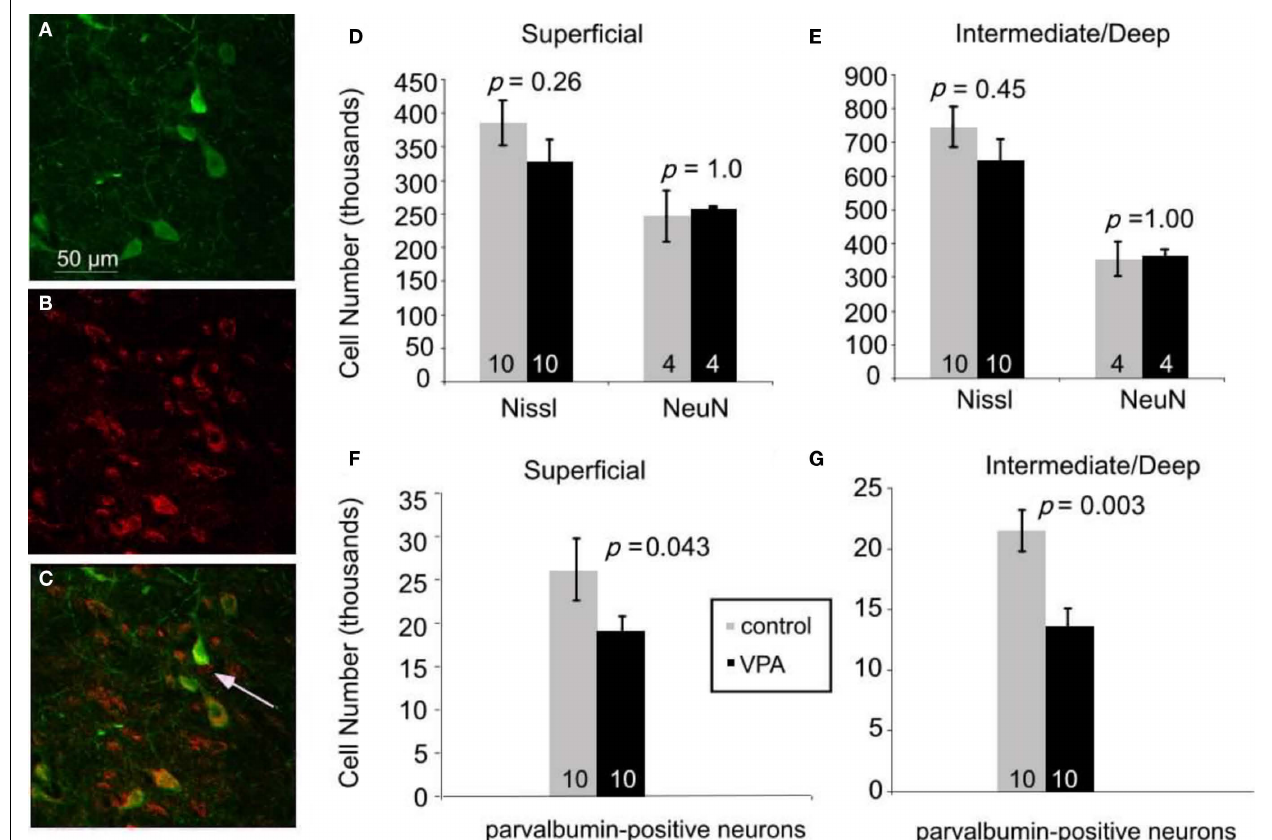
Nissl-stained cells and total number of neurons labeled with NeuN in the superficial (D) and the intermediate/deep (E) layers. (F,G) .VPA treatment results in significant reductions in the number of parvalbumin-positive neurons in the superficial (F) and the intermediate/deep (G) layers. Mann–Whitney U used for statistical analyses. Sample size is denoted by number on each